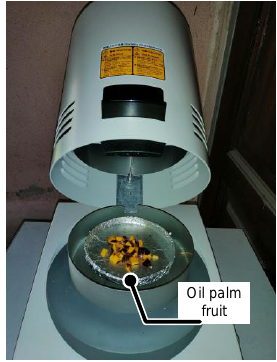
Figure 5. Drying process for moisture content.